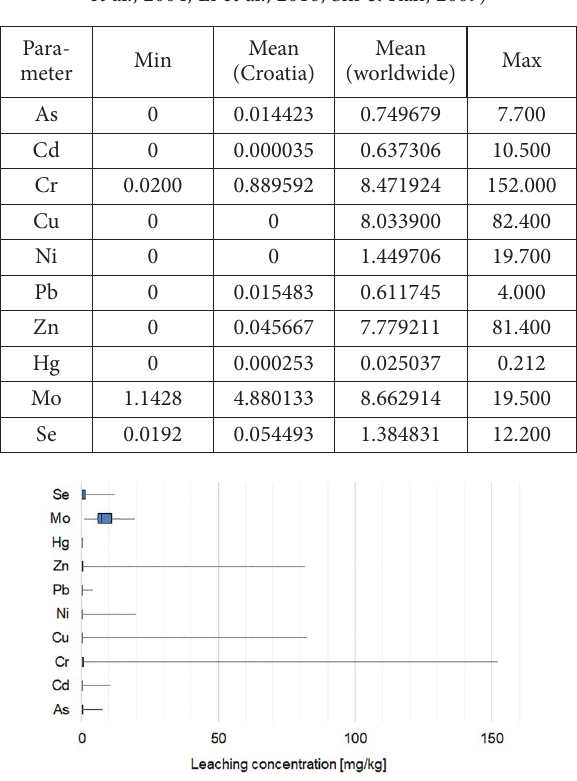
Figure 3. Range of heavy metal leaching concentrations – combined results of literature review and additional